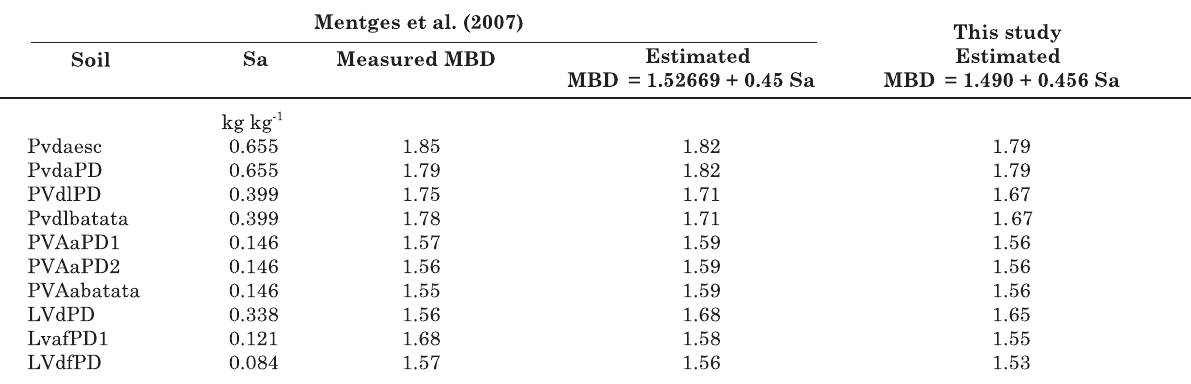
Table 6. Maximum bulk density (MBD) data of soils with different sand (Sa) contents cultivated under different management conditions. Column 3: measured by Mentges et al. (2007) based on the ‘Proctor test; column 4: estimated by the model of Mentges et al. (2007); column 5: estimated by the model proposed in this study